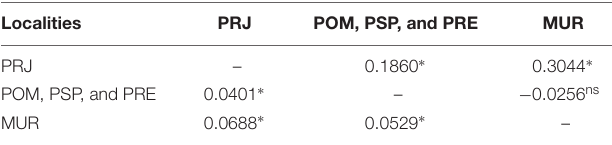
to their original collection area (hereafter termed populations). TABLE 1 | Pairwise mtDNA φ ST values (above diagonal) and pairwise Jost’s D EST values using microsatellites (below the diagonal) among three population clusters of Steindachneridion